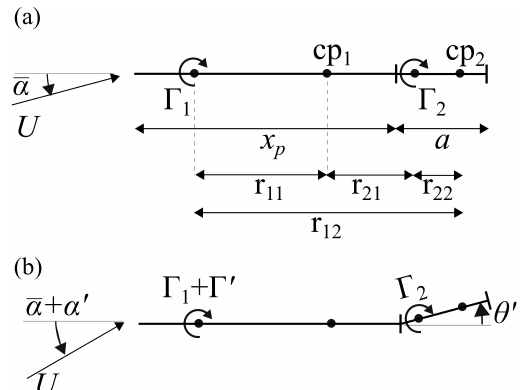
Fig. 4: Schematic diagram of the panel method used to model a flat plate with a flap, shown at the mean angular position in (a) and the deflected position in (b).